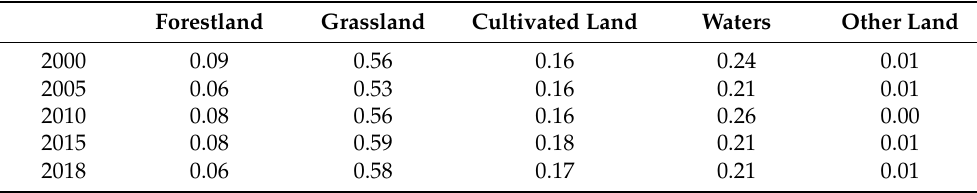
Table 5. Coefficient of sensitivity of ESV.